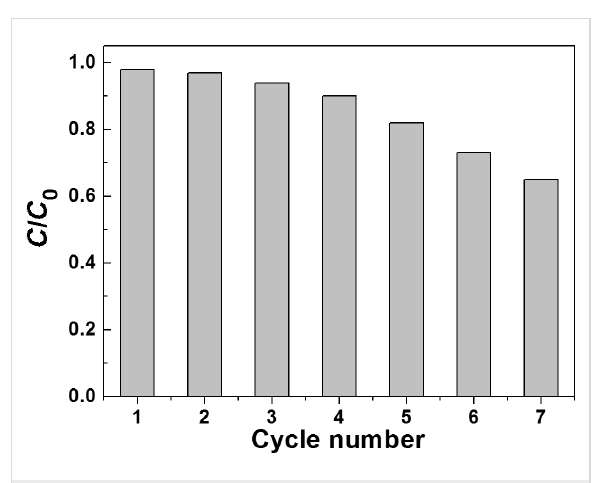
Figure 13: Recyclability of the ZnO:Ce photocatalyst.